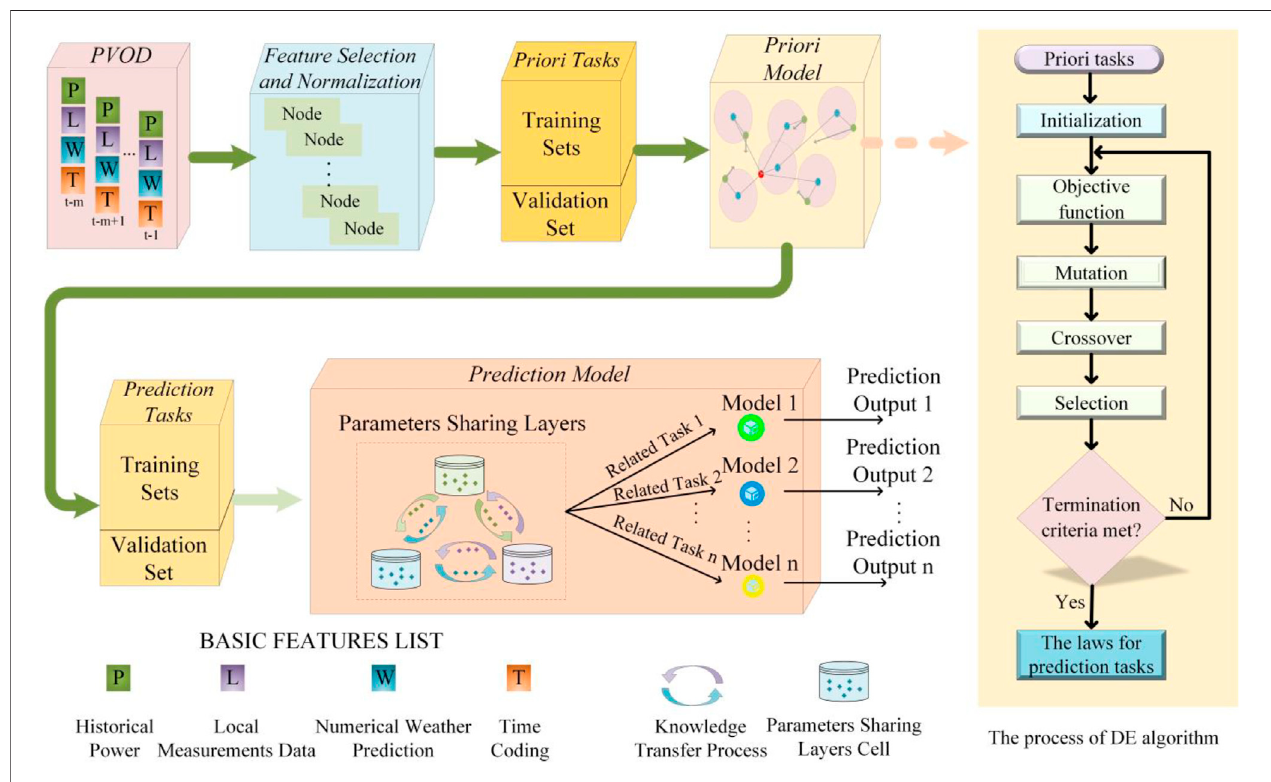
FIGURE 5 | The training process of the combined photovoltaic power prediction model.